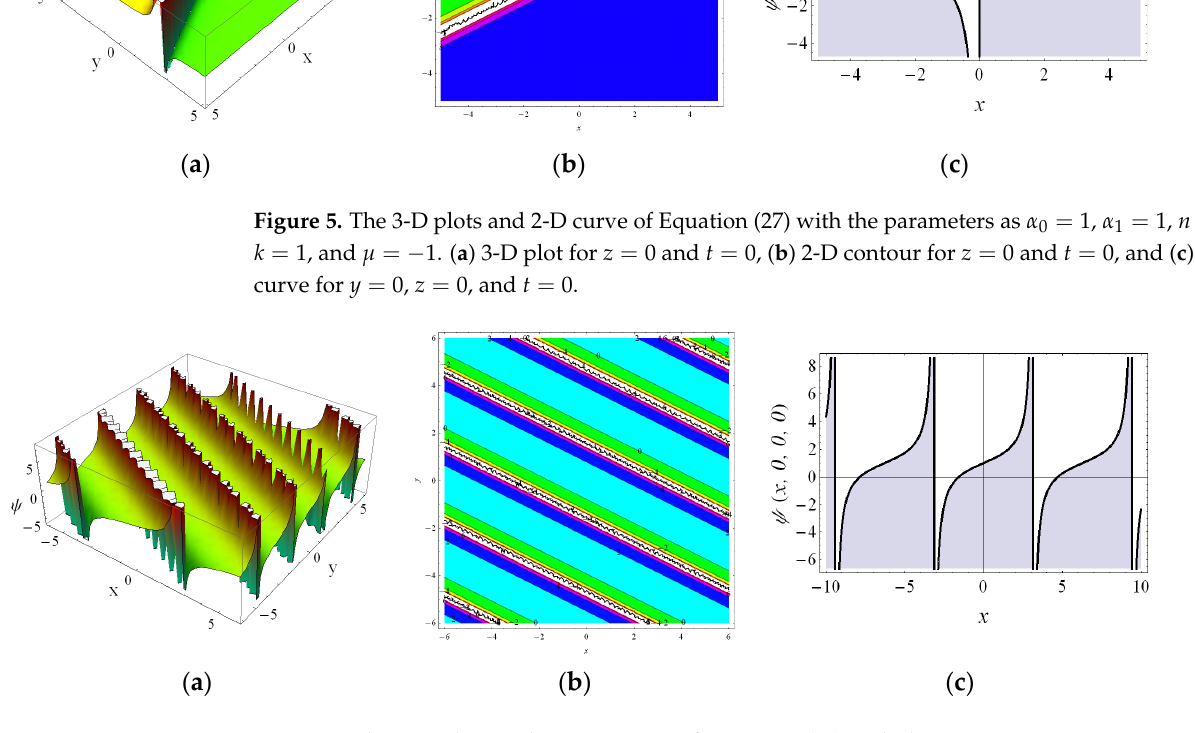
Figure 6. The 3-D plots and 2-D contours of Equation (28) with the parameters as α 0 = 1, α 1 = 1, n = 1, k = 1, and µ = 1. ( a ) 3-D plot for z = 0 and t = 0, ( b ) 2-D contour for z = 0 and t = 0, and ( c ) 2-D curve for y = 0, z = 0, and t = 0.